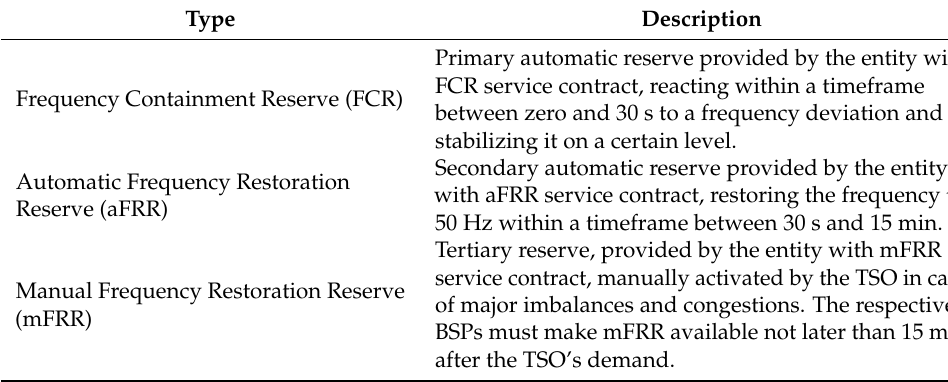
Table 1. Types of grid-balancing services